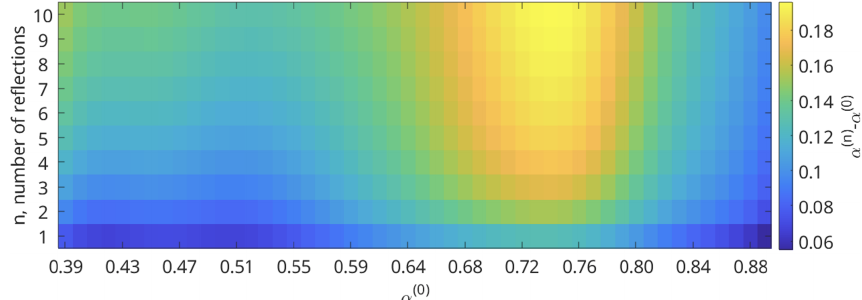
Figure 4. Increase in broadband albedo caused by internal reflections within an ablation hollow. The x axis shows the initial albedo from Eq. (8) covering a range of grain sizes and concentration of light-absorbing particles, and the y axis shows the number of reflections from 1 to 10. The intensity shows the resulting increase in albedo from Eq.